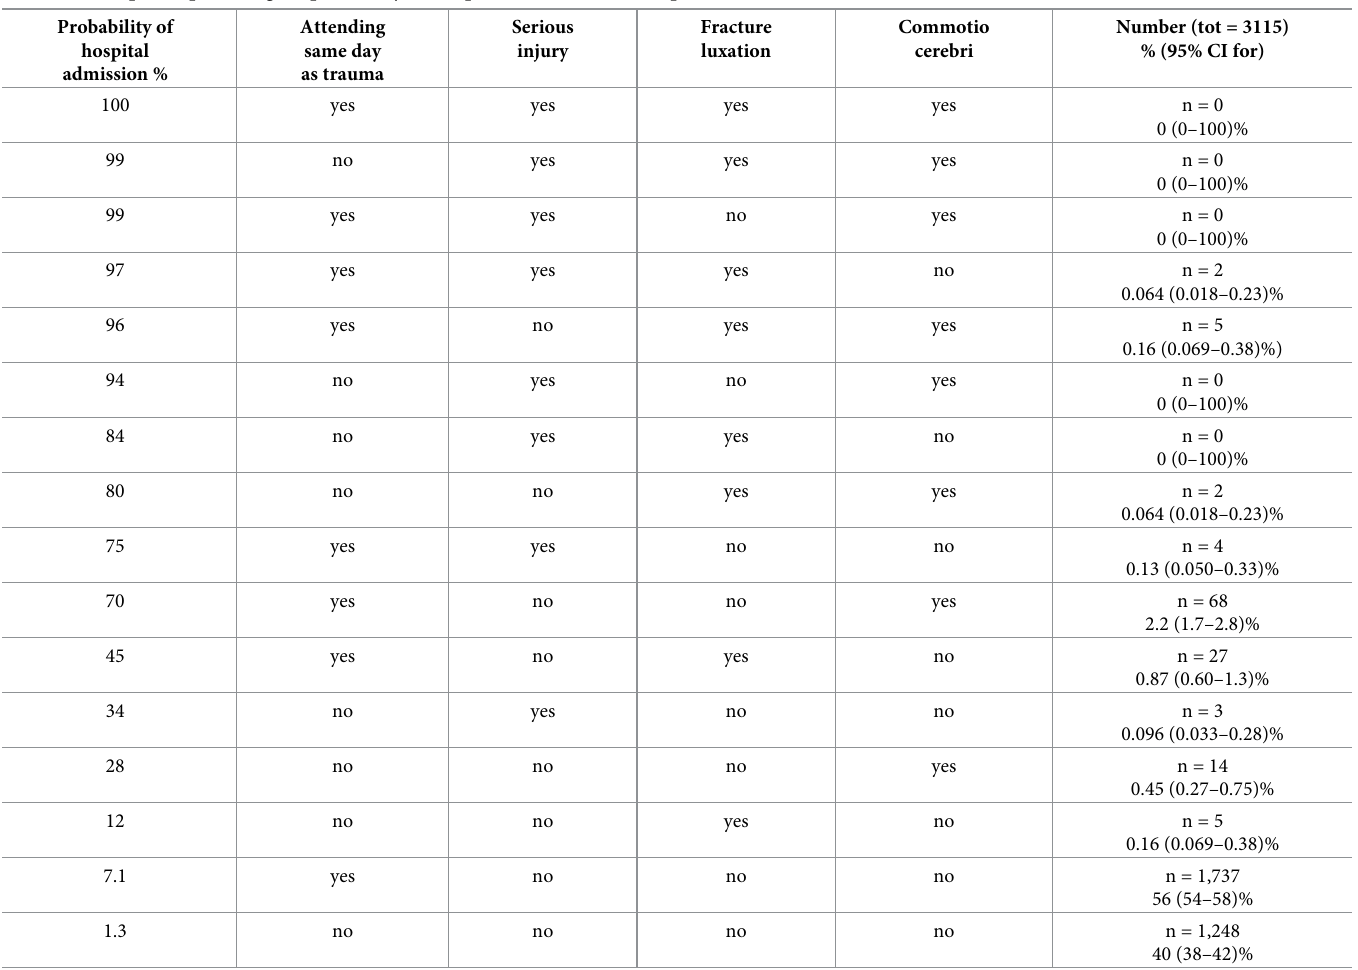
Table 3. Lookup table predicting the probability for hospital admission after whiplash